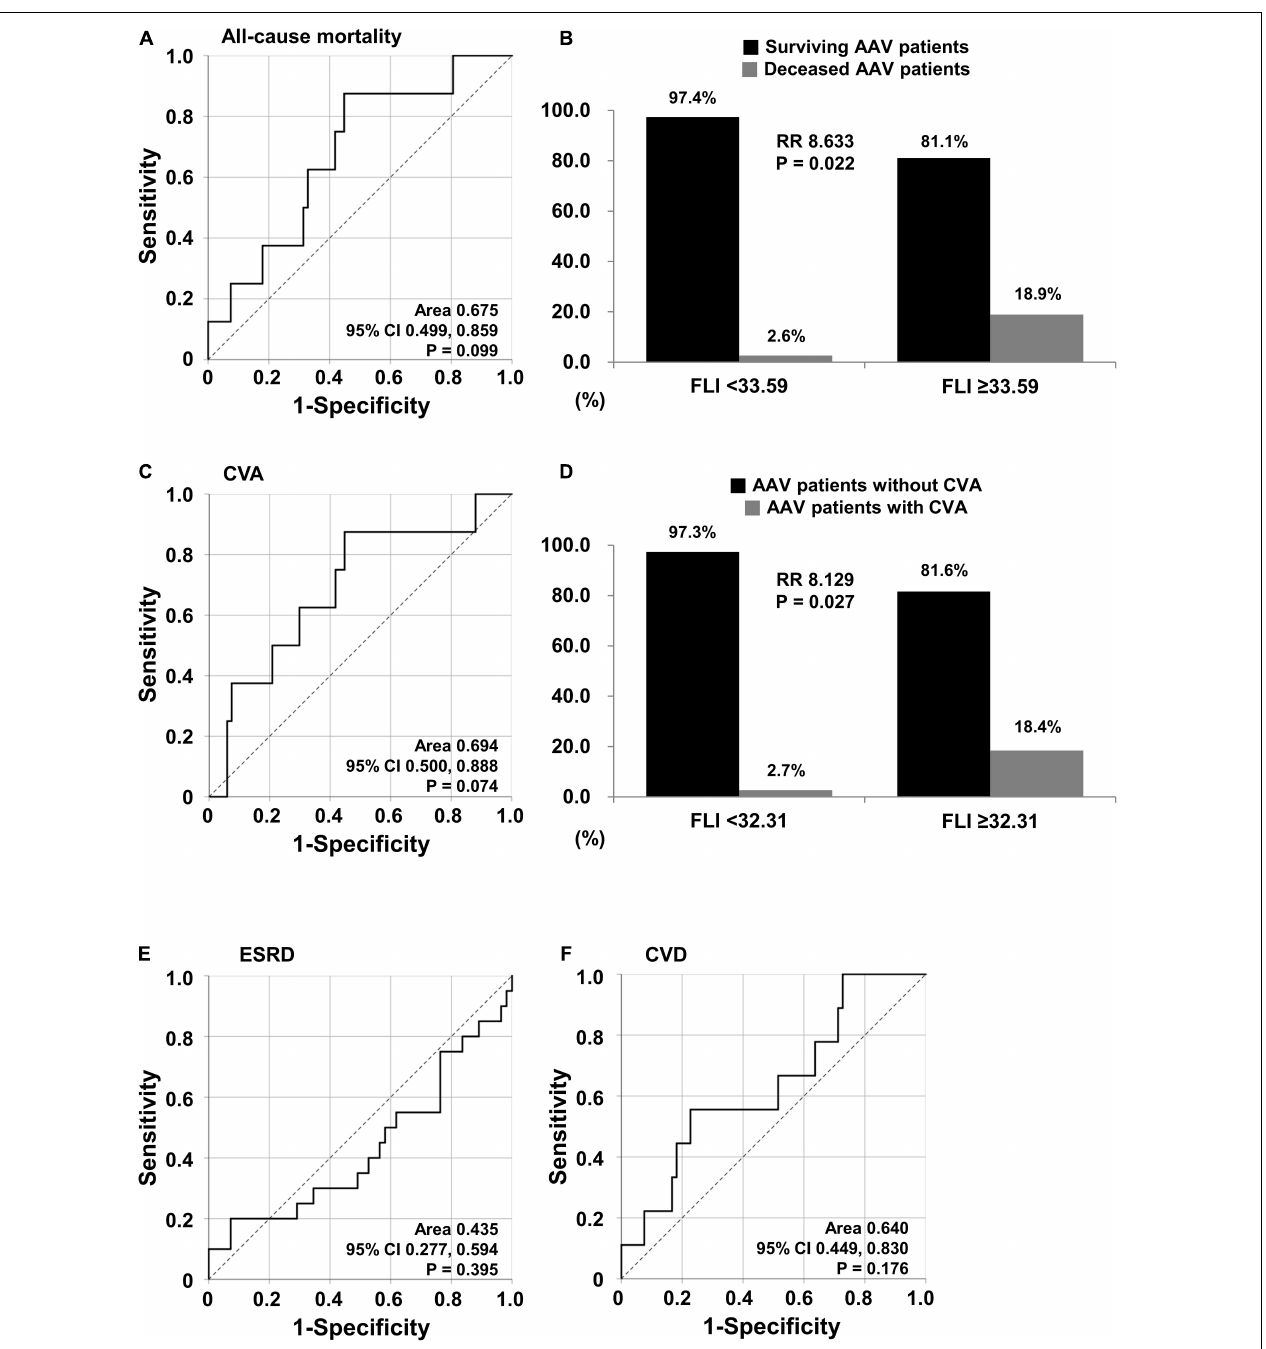
FIGURE 1 | Cut-offs of the FLI for all-cause mortality and CVA. (A) Identification of the cut-off of the FLI for all-cause mortality using the ROC curve. (B) RR of all-cause mortality according to the cut-off of the FLI. (C) Identification of the cut-off of the FLI for CVA using the ROC curve. (D) RR of CVA based on the cut-off of the FLI. (E,F) Identification of the cut-offs of the FLI for ESRD and CVD. FLI, fatty liver index; RR, relative risk; CVA, cerebrovascular accident; ROC, receiver operator characteristic; ESRD, end-stage renal disease; CVD, cardiovascular disease.